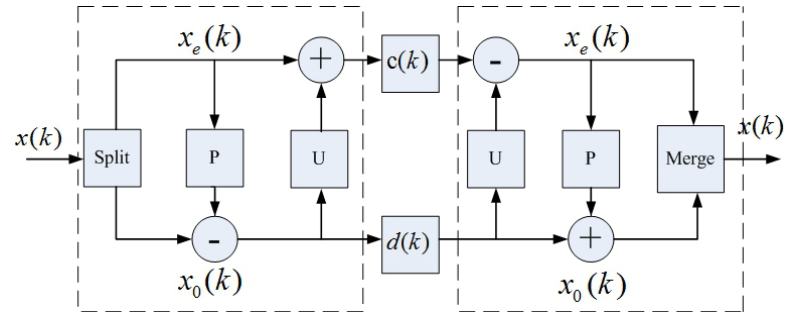
Figure 5. Structure of the lifting